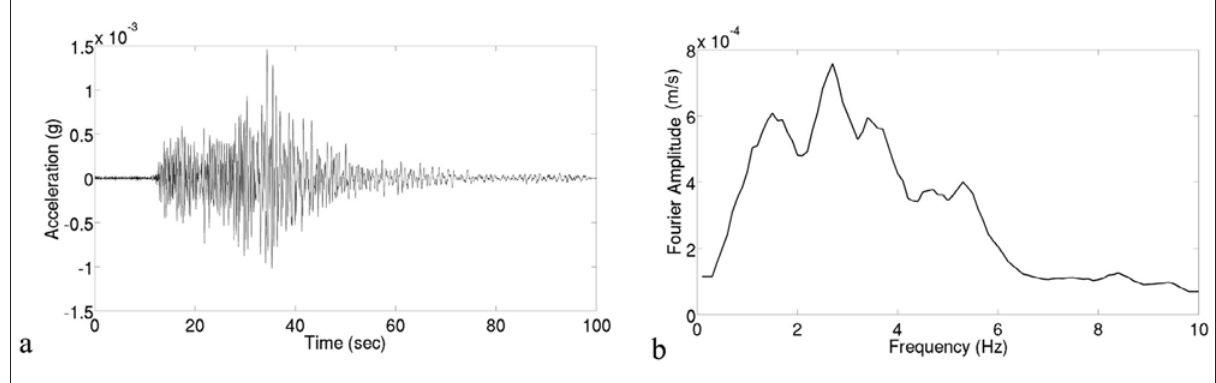
Figure 6. Time-history (a) and Fourier spectrum (b) of the earthquake recorded at the Fosso di Vallerano valley on 23 June 2009 here used for the visco-elastic numerical modelling.